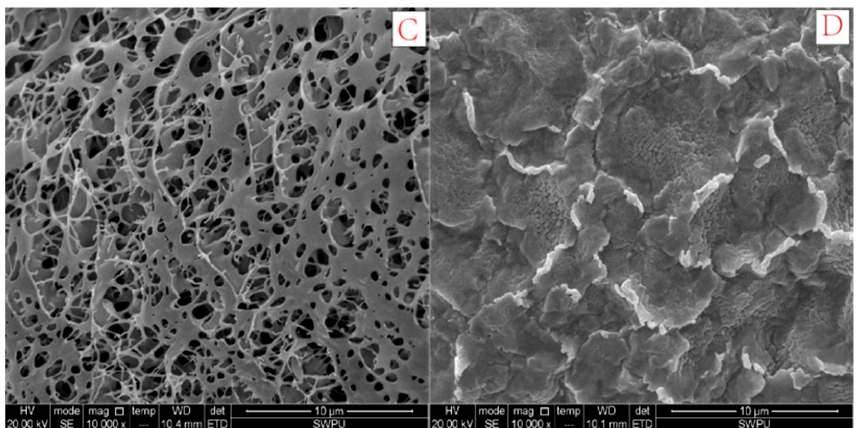
Figure 17. SEM images (×10,000) of a 0.3 wt% DiPHAM aqueous solution with different concentrations of Ca 2+ ions ( A ) 1000 mg/L; ( B ) 3000 mg/L; ( C ) 5000 mg/L; ( D ) 10,000 mg/L.